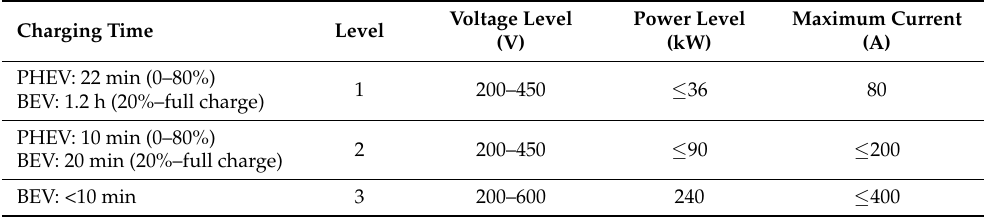
Table 3. Characteristics of DC level chargers.